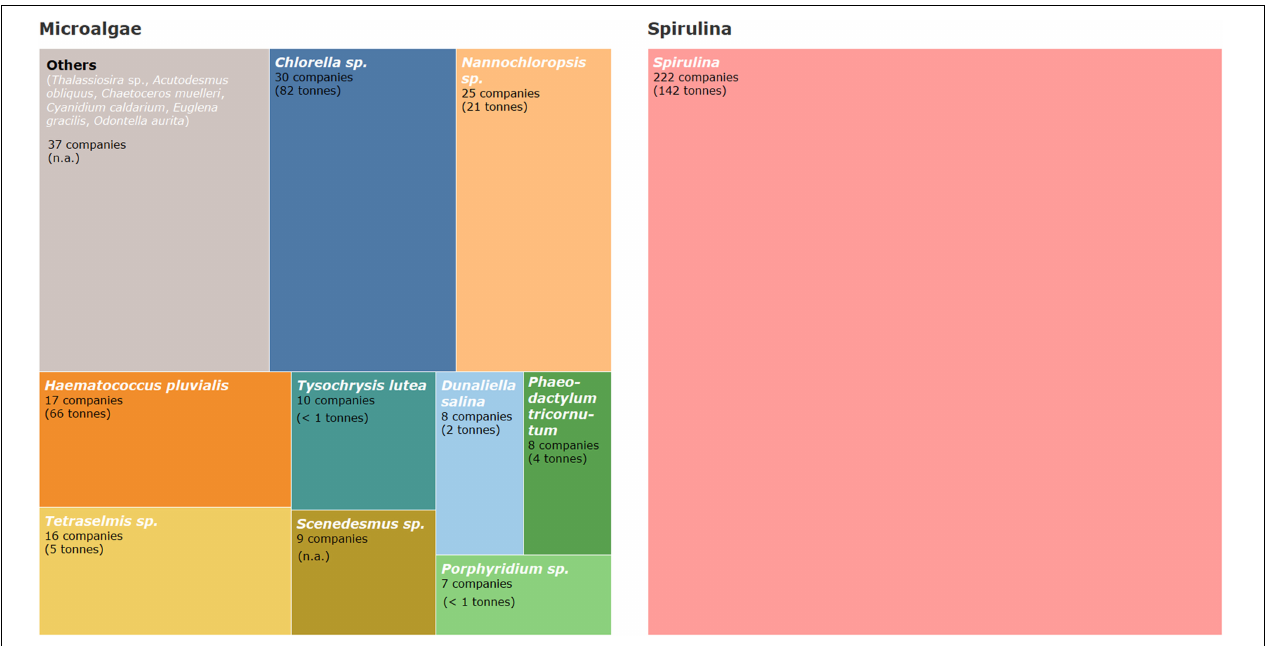
FIGURE 11 | Share of number of companies by microalgae species and Spirulina produced in Europe. Examples of the produced species included in the category “Others” are given. Production volumes are given per year by species at the European level whenever available (all numbers are in dry